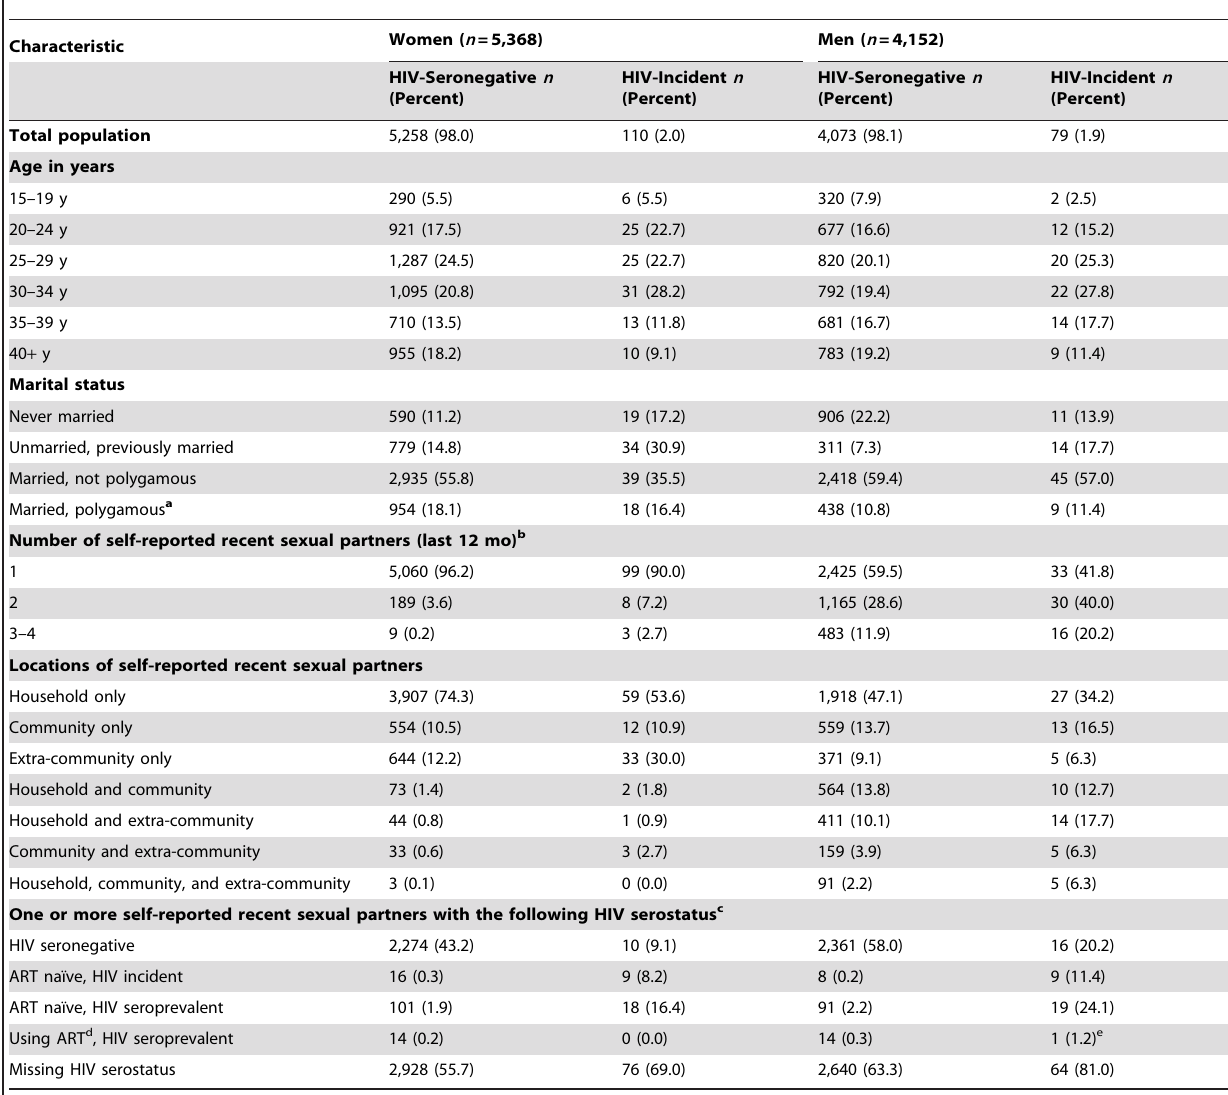
Table 3. Descriptive characteristics of HIV-seronegative and -incident participants in egocentric partner analysis ( n =9,520).